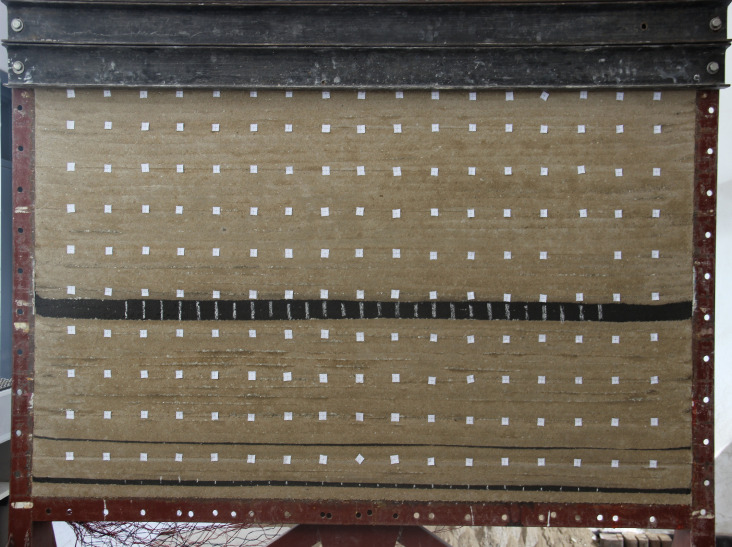
Experimental model.